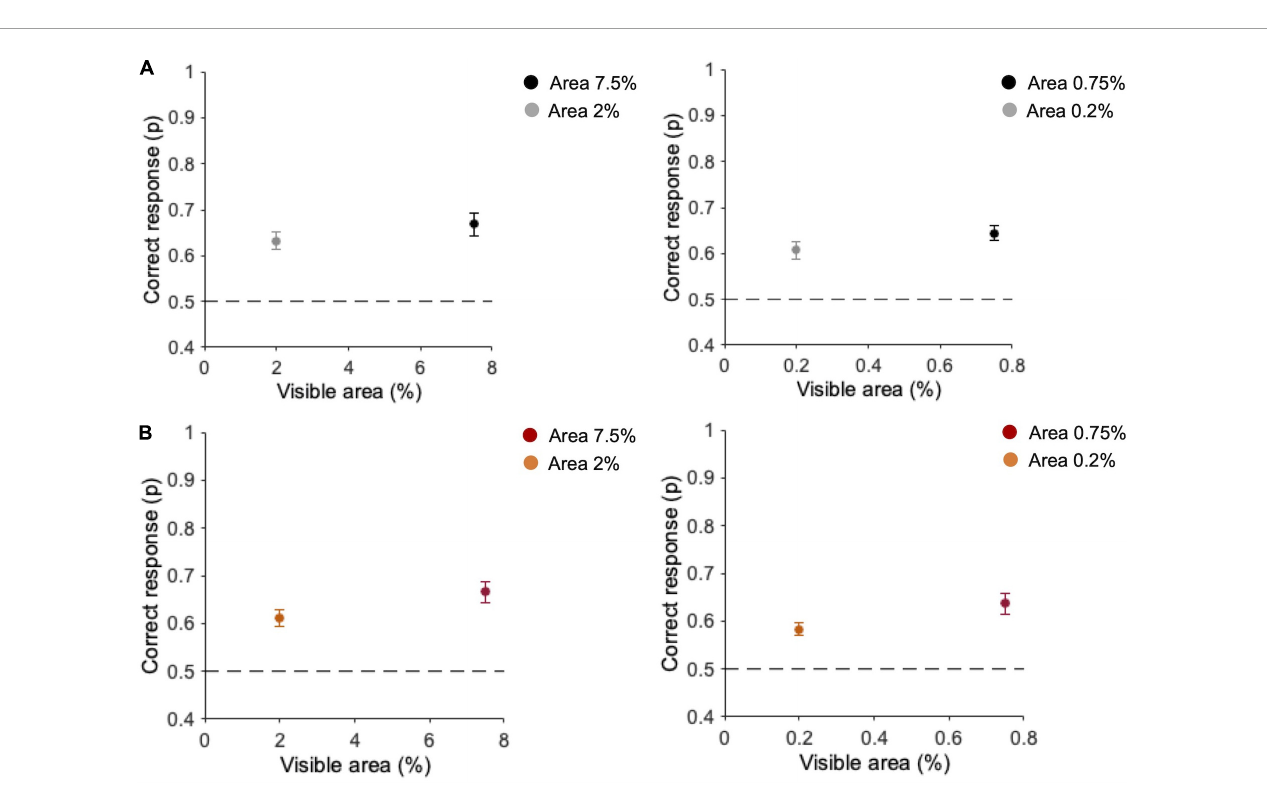
FIGURE4 Performance for different areas and number of fragments. (A) Task with original-contrast images. (B) Task with randomly inverted-contrast images. Left panels: average performance ( n = 10) for ten fragments (2 and 7.5% of area); Right panels: average performance ( n = 10) for one fragment (0.2 and 0.75% of area). Errors are SE across participants. Observers performed 2,400 trials in total (300 trials for each condition).